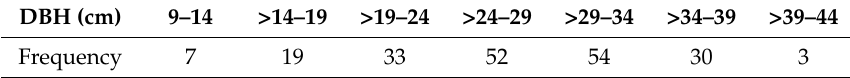
Table 3. Diameter at breast height (DBH) distribution ( n =